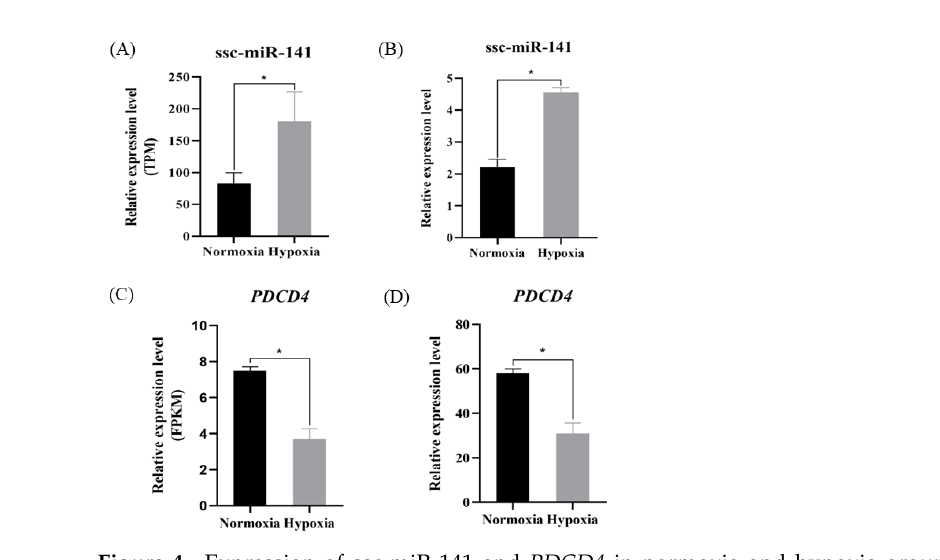
Figure 4. Expression of ssc-miR-141 and PDCD4 in normoxia and hypoxia groups (ATII cells). ( A , C ) indicates the expression of ssc-miR-141, PDCD4 RNA-seq in normoxia/hypoxia; ( B , D ) indicates the expression of ssc-miR-141, PDCD4 RT-qPCR in normoxia/hypoxia. * indicates p < 0.05.